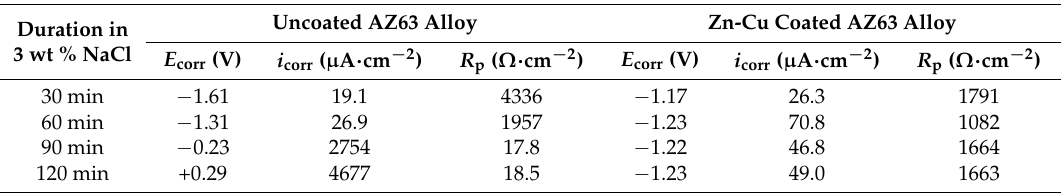
Table 1. E corr and i corr parameters extracted from Tafel plot of Figure 4 in artificial seawater. R p is calculated from the Sterm-Geary